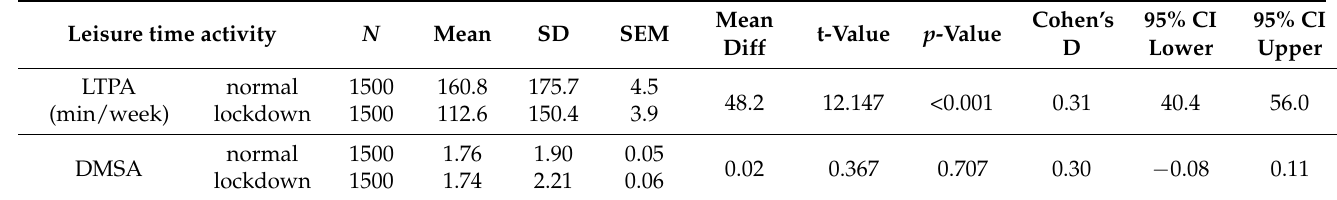
Table 7. Leisure time